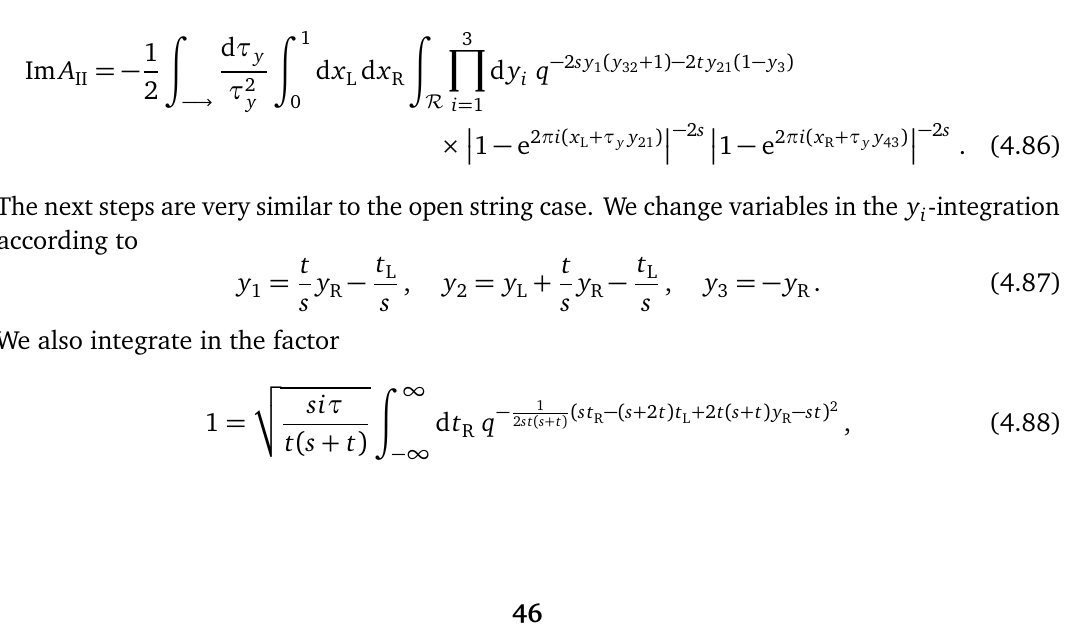
Figure 21: The two regions in the ( y negative. The picture is drawn for s = 1 and t = − 1 region, since y is identified 3